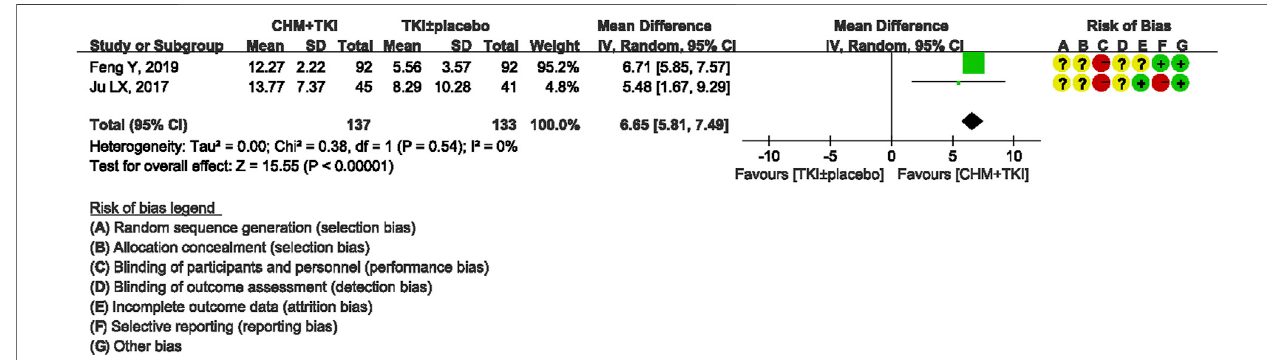
FIGURE 5 | Forest plot showing changes in